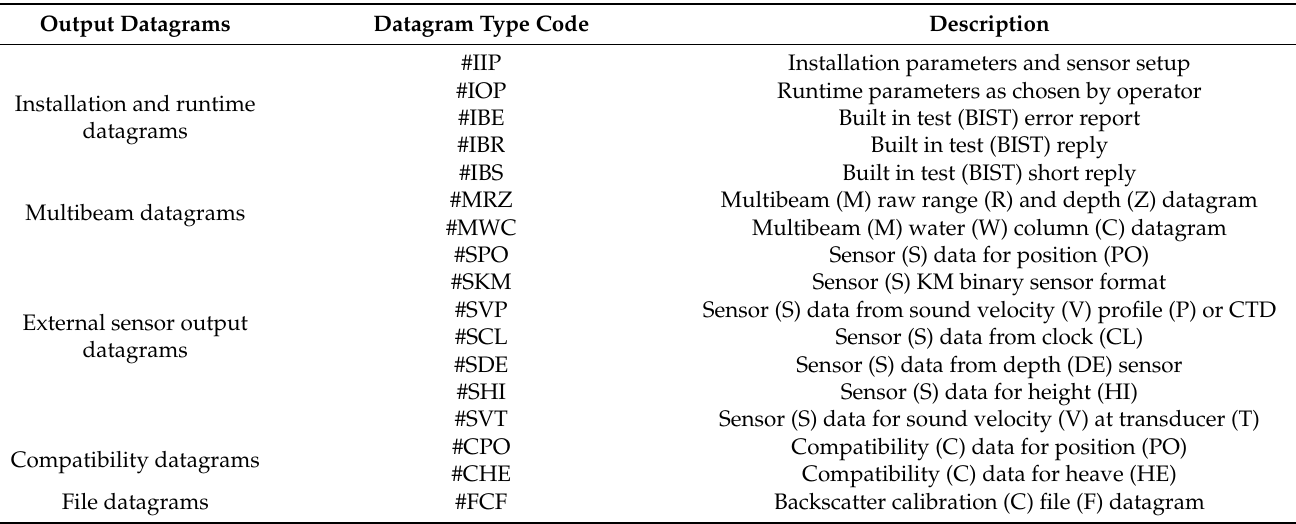
Table 1. EM datagrams on.kmall format.